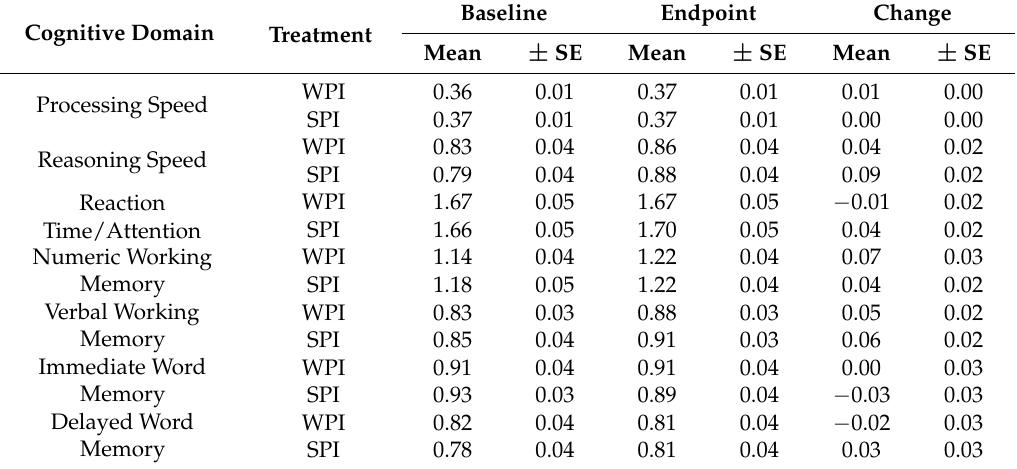
Table 3. Means ( ± standard error of the mean) for cognitive variables at baseline, endpoint and for overall